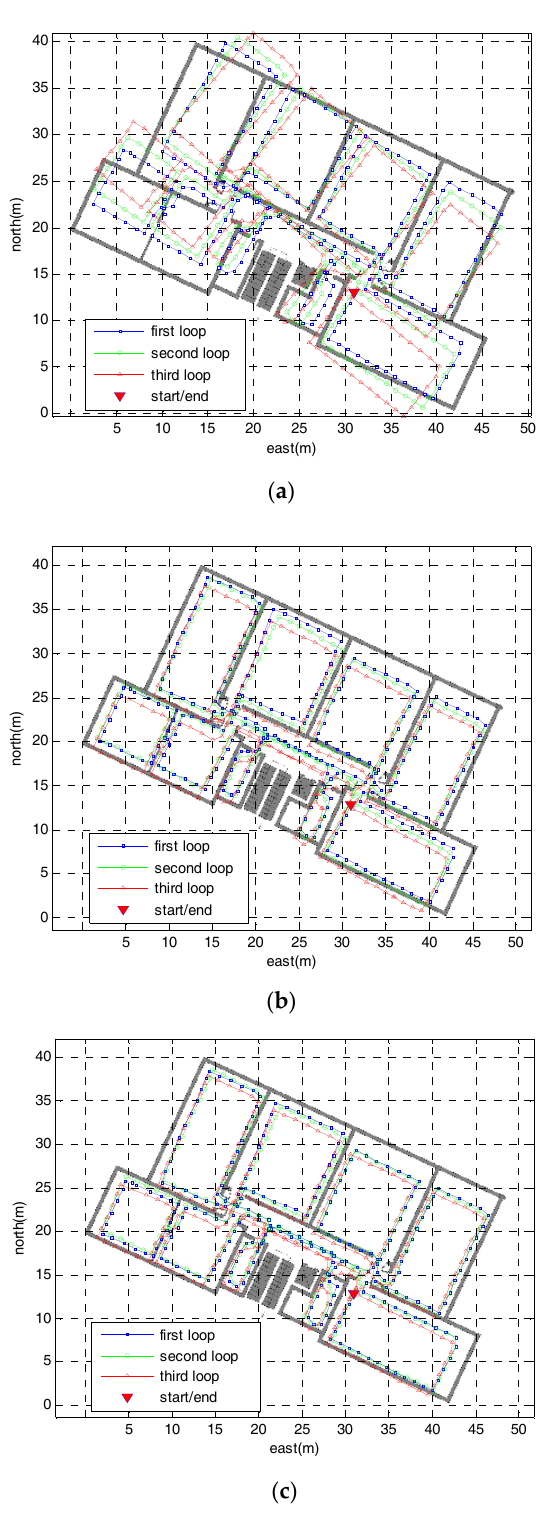
Figure 10. The step-wise trajectories of the office test: ( a ) Step-wise trajectory of the pure ZUPT method;